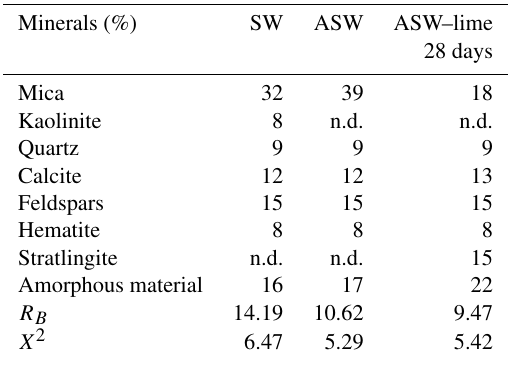
Figure 1. Evolution of the pozzolanic activity from the activated products.